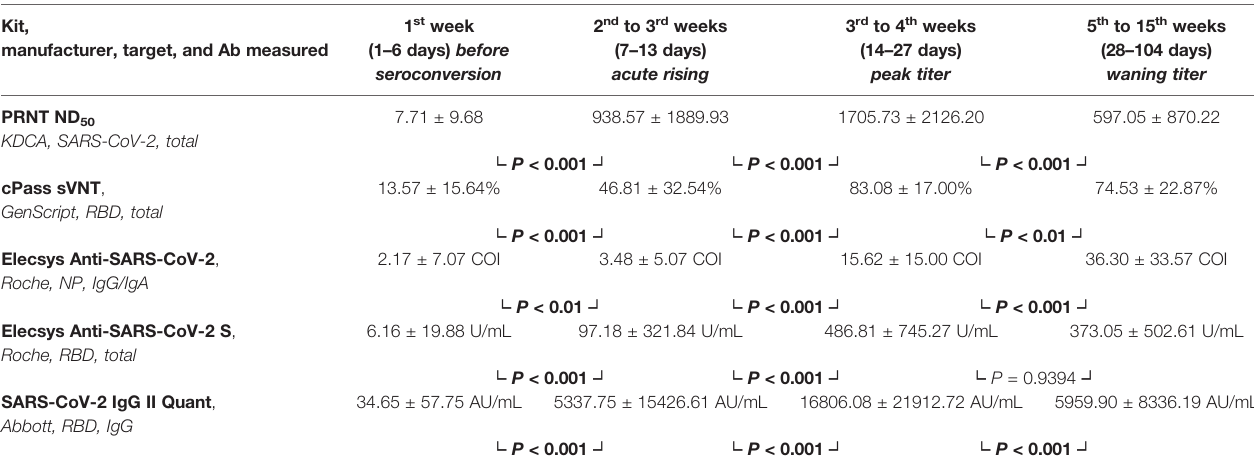
TABLE 5 | Antibody titers by timeline.